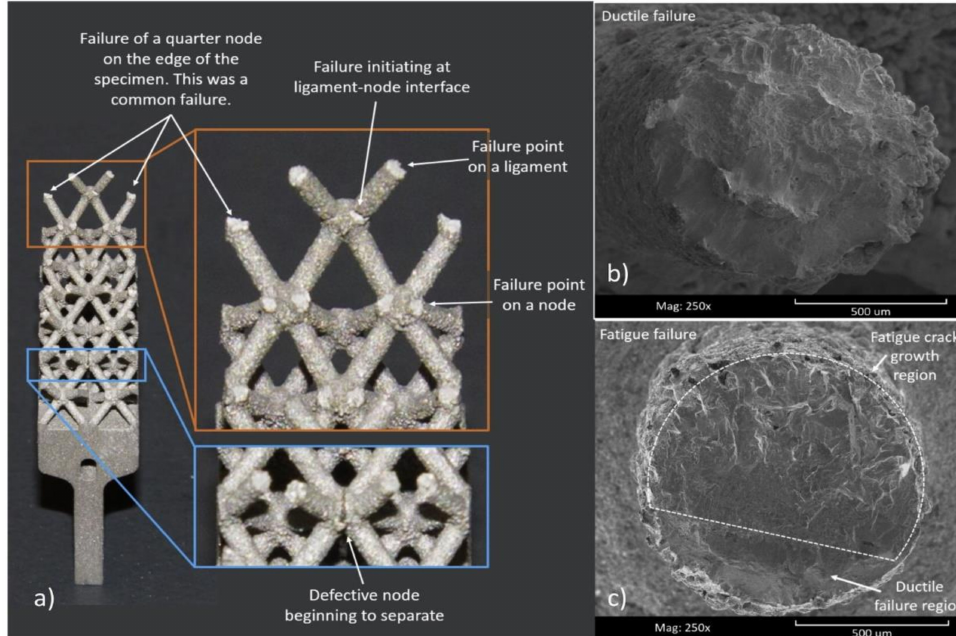
Figure 18. ( a ) Fatigued micro truss showing failure at the ligament-node interfaces and through the quarter nodes at the edge of the specimens. SEM images of ligament fracture surfaces showing two failure mechanisms. ( b ) this ligament experienced catastrophic ductile failure after much of the rest of the micro truss had failed. ( c ) this ligament failed in fatigue and was one of the first ligaments to fail. Reprinted with permission from ref. [78]. 2018,